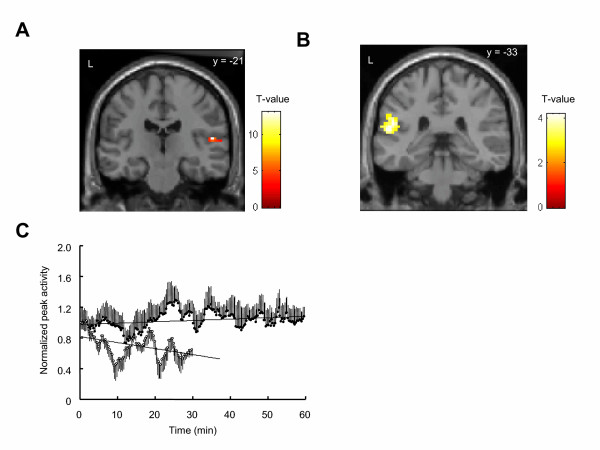
Activity related to noise reduction by regression analyses. Brain regions in which responsiveness to transient noise reduction was decreased in the CFS patients (A), and those in which responsiveness to transient noise reduction was decreased in the CFS patients relative to the normal subjects (B) during the fatigue session over 30 min (P < 0.05, uncorrected) are shown. Brain regions shown in Figure 6A and B are limited within auditory cortices. Anatomical locations were mapped on coronal template brains, with coordinate in mm from the anterior commissure. The left side (L) is indicated. (C) Time course of 10-event moving-averaged normalised peak activity of the left planum temporale. Normalised peak activity was calculated as shown in 'Materials and Methods' section. Linear regression lines are shown. Closed circles, normal subjects; open circles, CFS subjects. Data are mean and SEM.